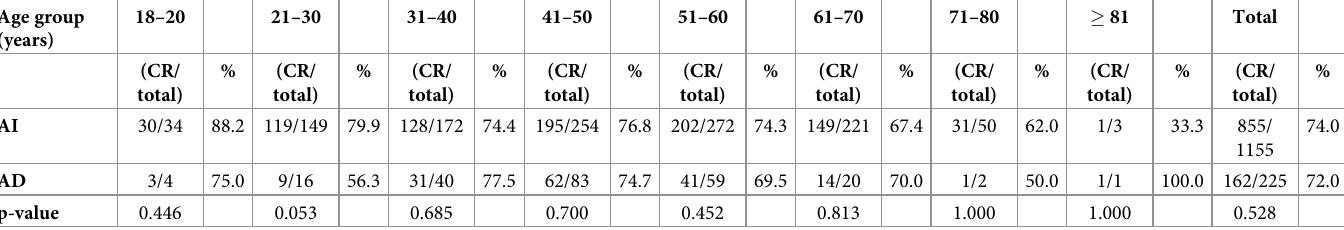
Table 2. Comparison of complete remission (CR) rates between patients receiving the cytarabine plus idarubicin (AI) and cytarabine plus daunorubicin (AD) treat- ment regimens according to age group. Age group (years)